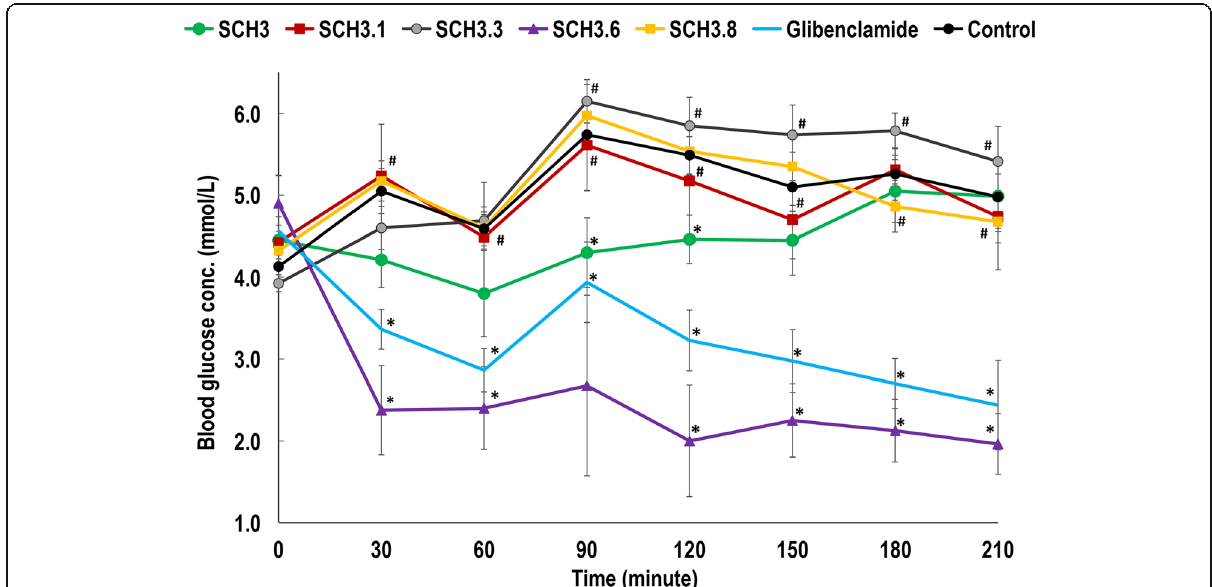
Fig. 2 Effect of sub-fractions (10 mg/kg BW) from SCH3 and glibenclamide (5 mg/kg BW) on blood glucose concentration. Data expressed as mean ± SEM ( n = 5); * represents p < 0.05 vs control and # represent p < 0.05 vs glibenclamide